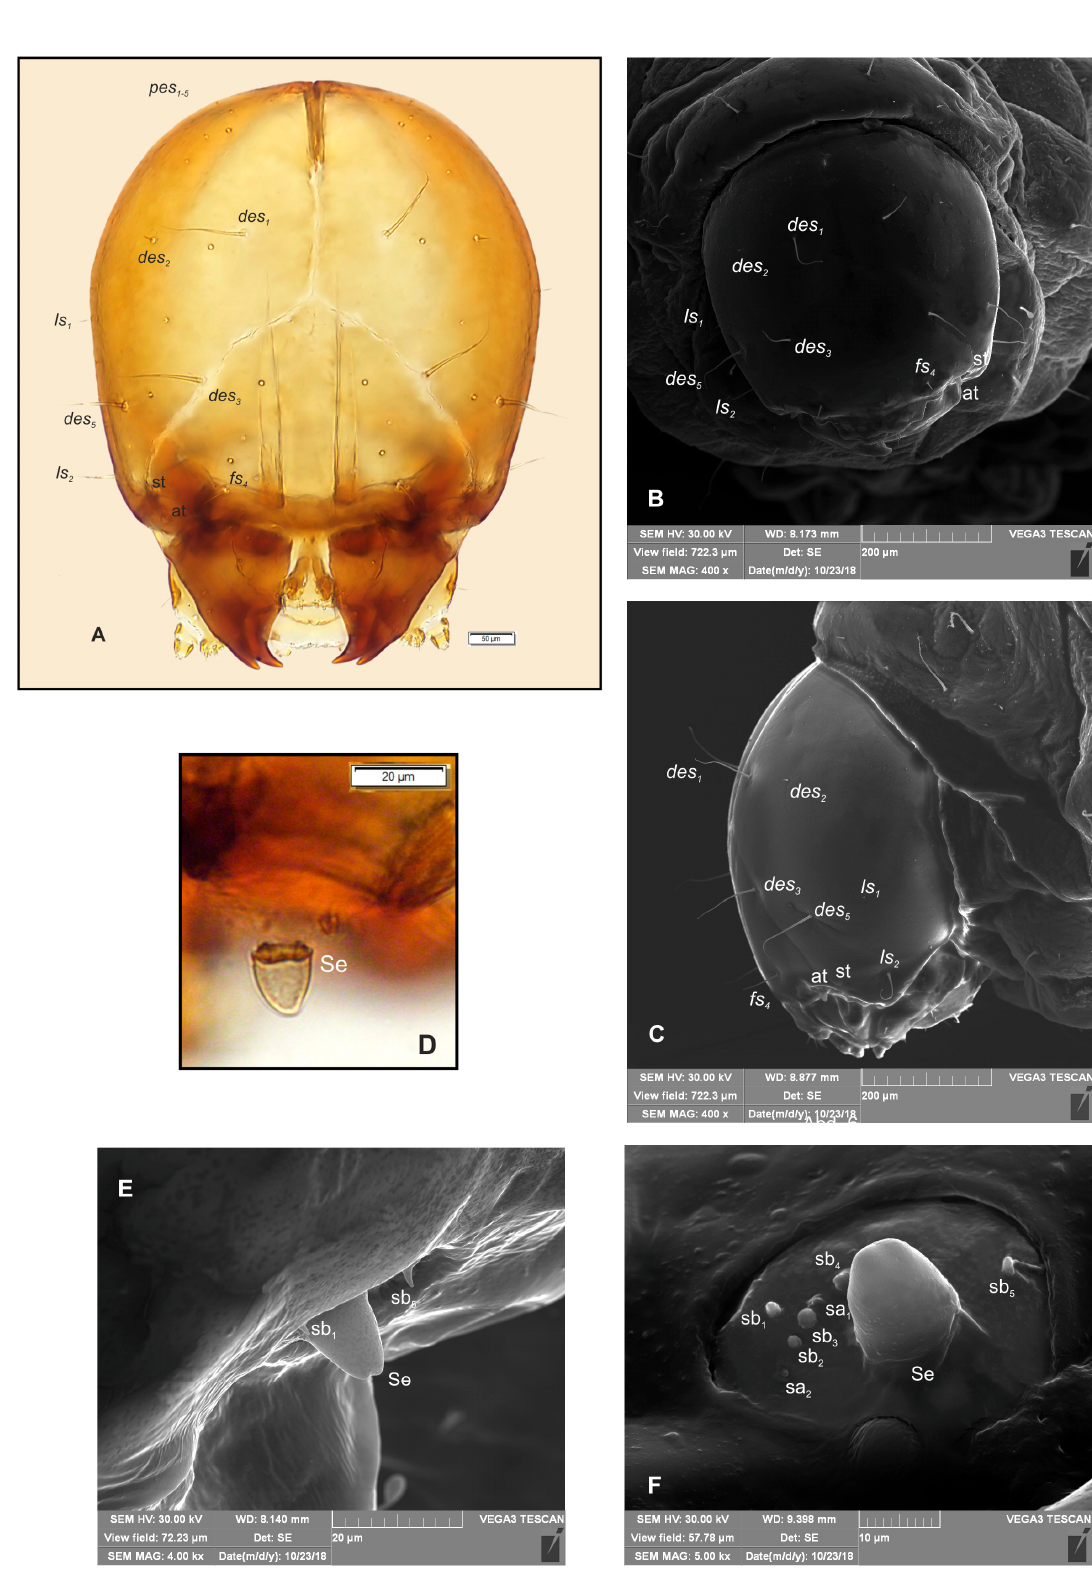
Figure 3. Bagous claudicans mature larva, head and antenna. A —head, frontal view; B —head, frontal view, SEM photography; C —head, lateral view, SEM photography; D —antenna, lateral view; E —antenna, lateral view, SEM photography; F —antenna, frontal view, SEM photography (at—antenna, sa—sensillum ampullaceum, sb—sensillum basiconicum, Se—sensorium, st—stemmata, setae: des —dorsal epicranial, fs —frontal, ls —lateral epicranial, pes —postepicranial).